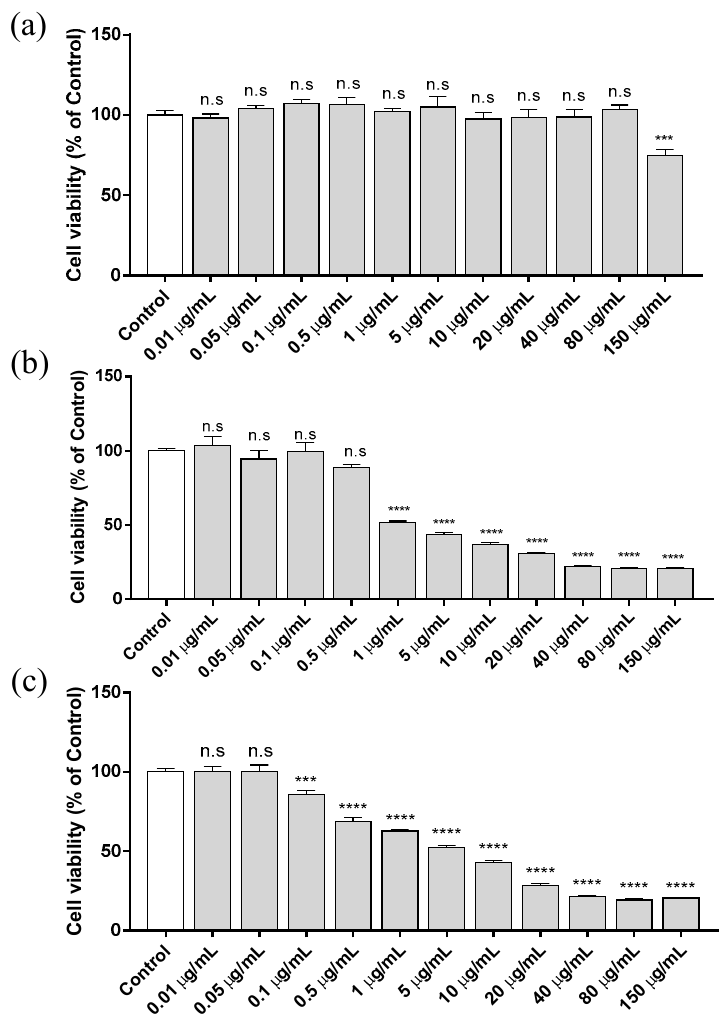
Figure 1. Cell viability in human keratinocyte HaCaT cells, after 3 ( a ), 12 ( b ), and 24 ( c ) h of exposure to different concentrations of graphene oxide (GO) ranging from 0.01 to 150 µg/mL. Cell viability was evaluated by the 3-(4, 5-dimethylthiazol-2-yl)-2, 5-diphenyl tetrazolium (MTT) assay. Results are represented as a percentage of the control group. Data are presented as the mean ± standard error of six replicates. The ANOVA results of the different GO concentrations with respect to control are indicated in the plot. *** p > 0.01; **** p > 0.001; n.s: not significant. Table 2. Mean effective concentration (EC 50 ) of HaCaT cells after treatment with graphene oxide (GO) at different exposure times. Mean EC 50 and 95% confidence intervals (CI) are shown as the GO mass–volume concentration, µg/mL. Goodness of fit (R square) is also indicated.